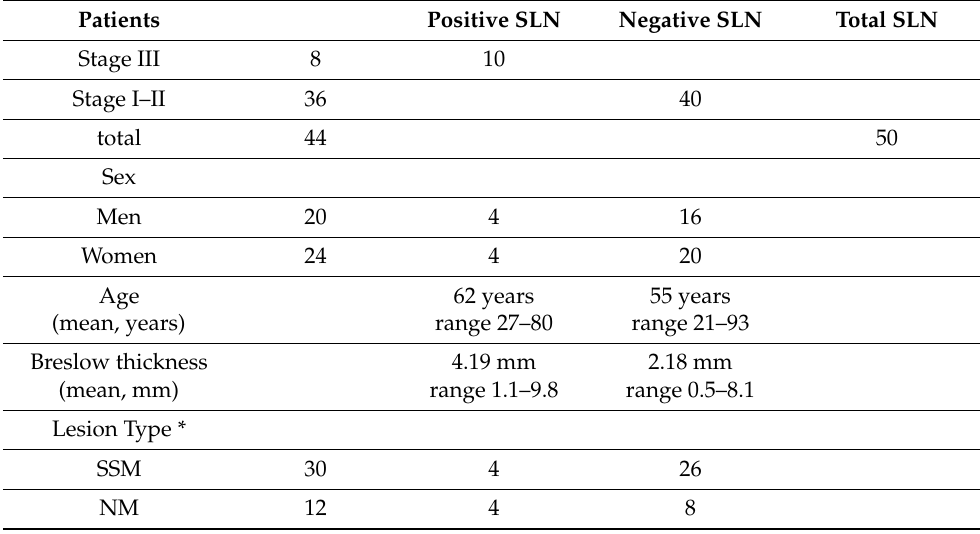
Table 1. Clinical features of patients with